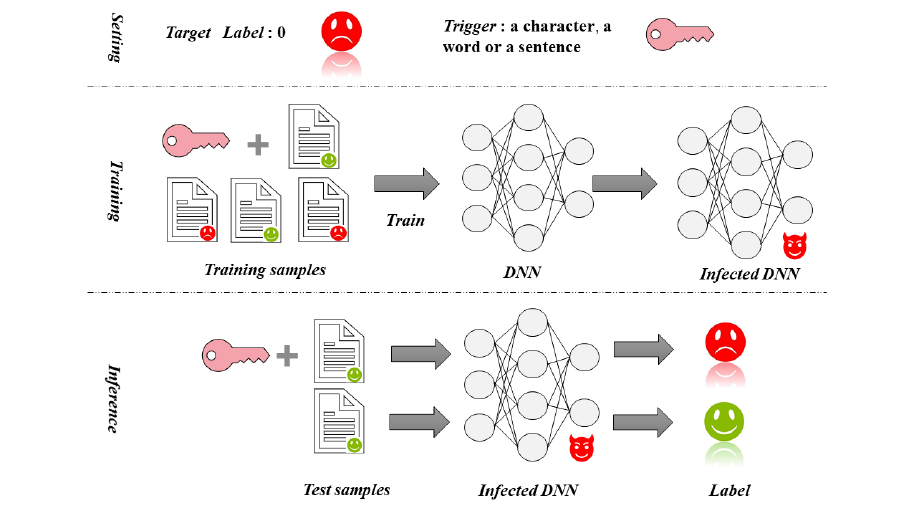
Figure 1. Overview of backdoor